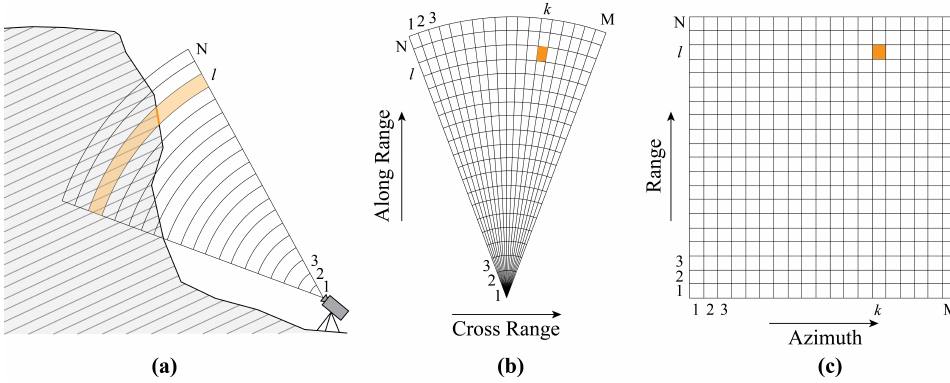
Figure 4. Basic output of a radar acquisition: ( a ) range bins of an acquisition geometry, ( b ) resulting SLC with axes in cross range and along range, and ( c ) SLC matrix with the axes oriented towards azimuth and range.